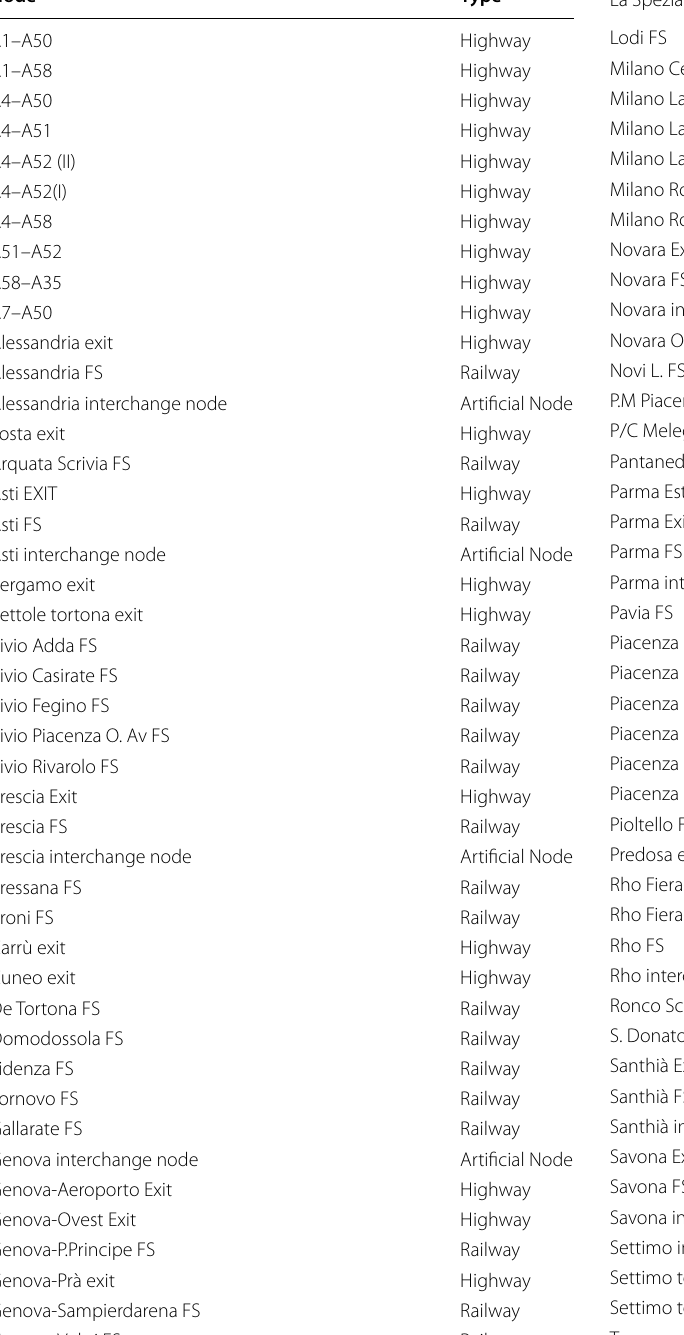
Table 5 Full list of nodes: motorway exits, railways station and artificial interchange